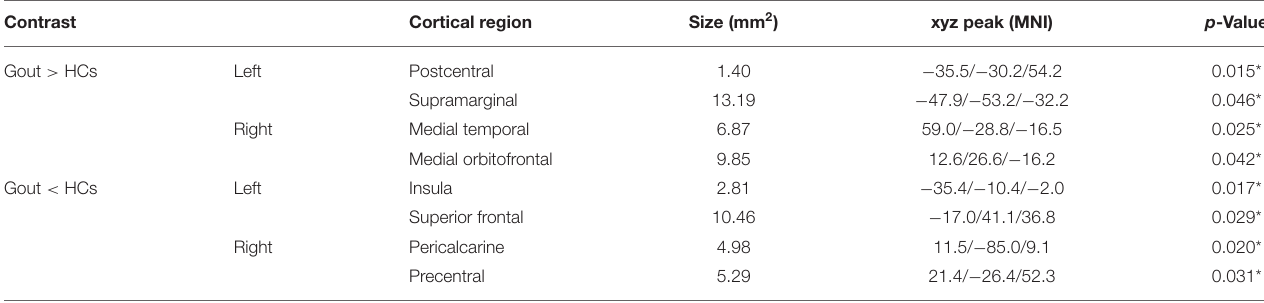
TABLE 1 | Regional changes in cortical thickness in the gout group compared with